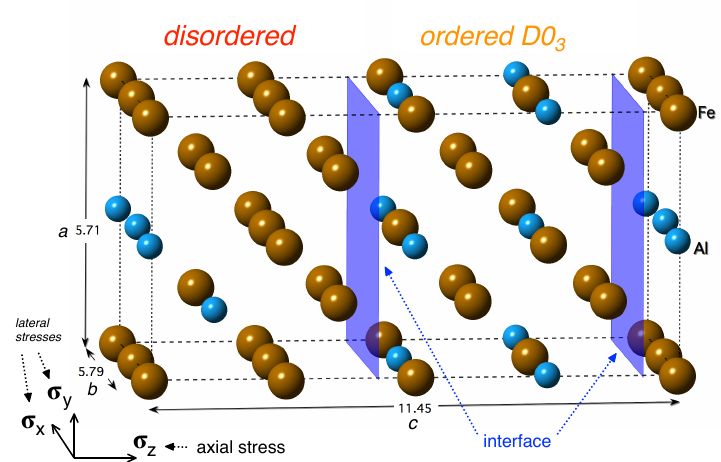
Figure 1. A schematic visualization of a supercell used in our ab initio calculations. The 32-atom supercell contains a disordered Fe-Al phase (left-hand side) and an ordered Fe 3 Al compound with the D0 3 structure (right-hand side). The interface between both phases is highlighted by the blue